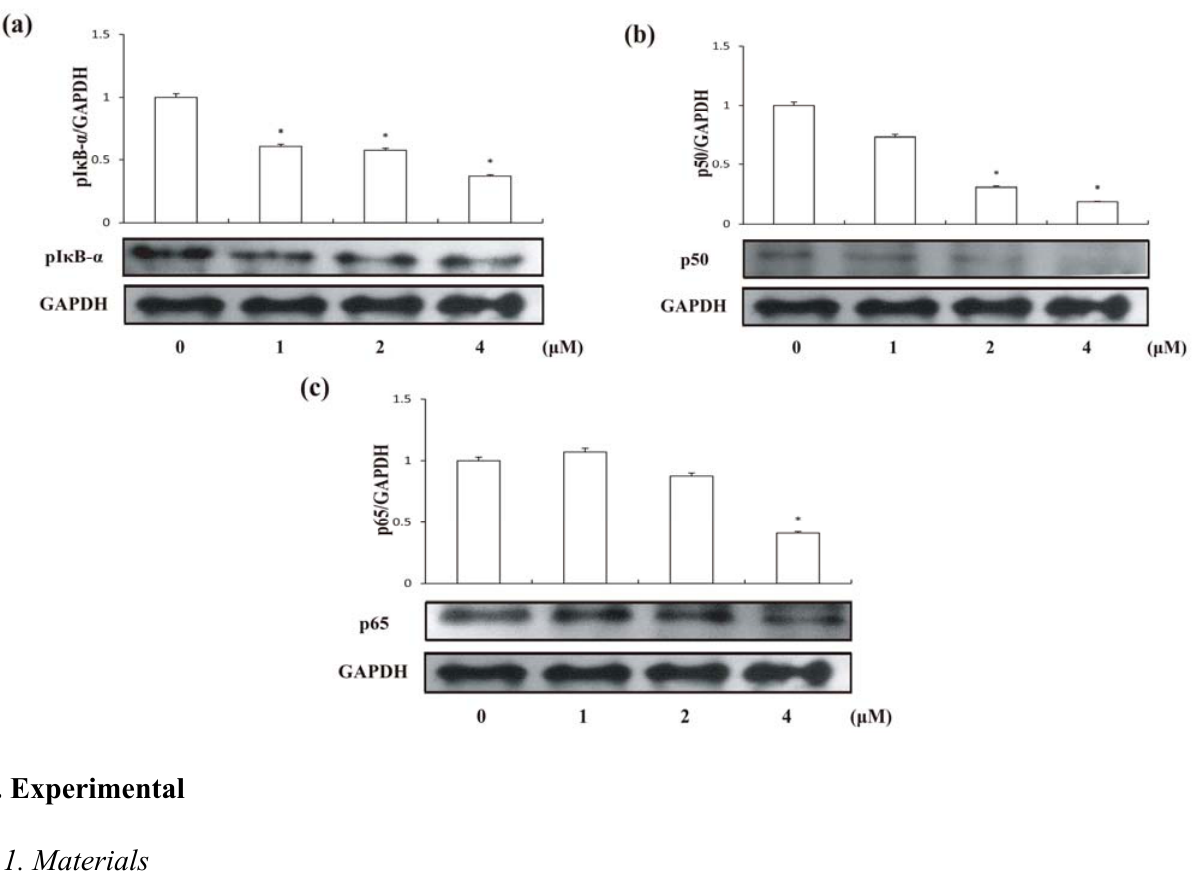
Figure 7. Expression levels of p50, p65 and phosphorylated I κ B- α in HCT-8 cells treated by compound 1 at different concentrations for 24 h; ( a ) pI κ B- α ; ( b ) p50; ( c )